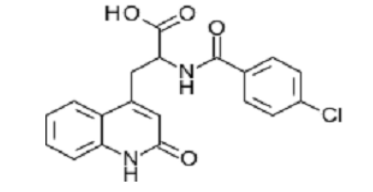
Figure 1. The chemical structure of REM